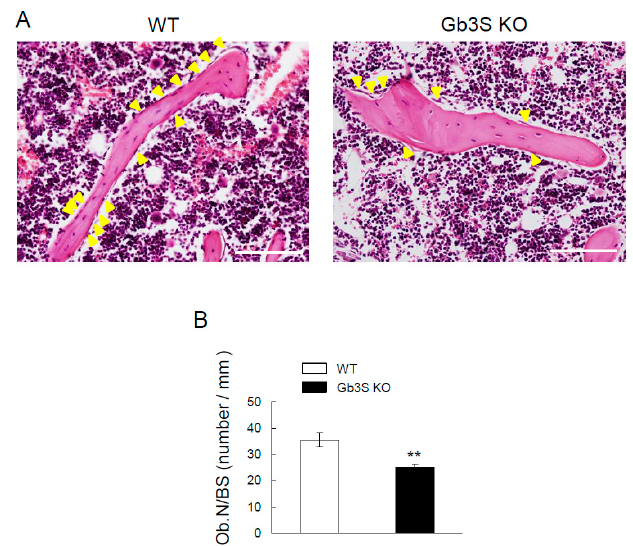
Figure 6. Decrease in osteoblast numbers by Gb3 synthase deficiency in 15-week-old mice (male, n = 10 for WT, n = 10 for Gb3S KO). ( A ) Images of hematoxylin and eosin (HE) staining of femoral cancellous bone. Results for WT mice (left) and Gb3S KO mice (right) are shown. The scale bars are 100 µ m. Yellow arrow heads indicate osteoblasts. ( B ) Osteoblast numbers / bone surface (Ob.N / BS, number / mm). Data are expressed as mean ± S.D. The double asterisks indicate p < 0.01.